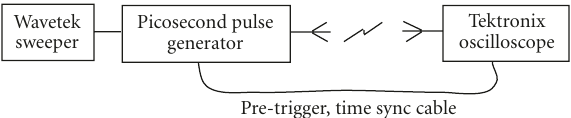
Figure 1: Connections of channel sounding apparatus.